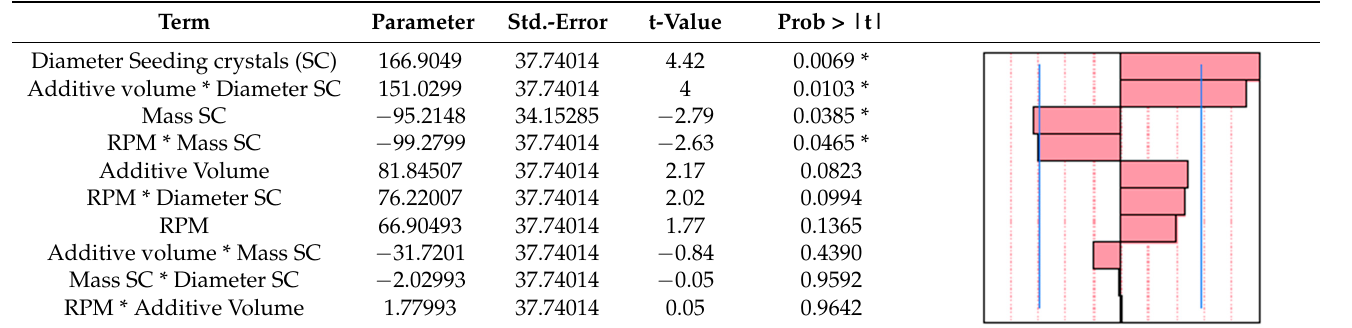
Table 3. Parameter influence on the crystal size ( x 63 ) . The terms marked with a star (*) are statistically significant. Term